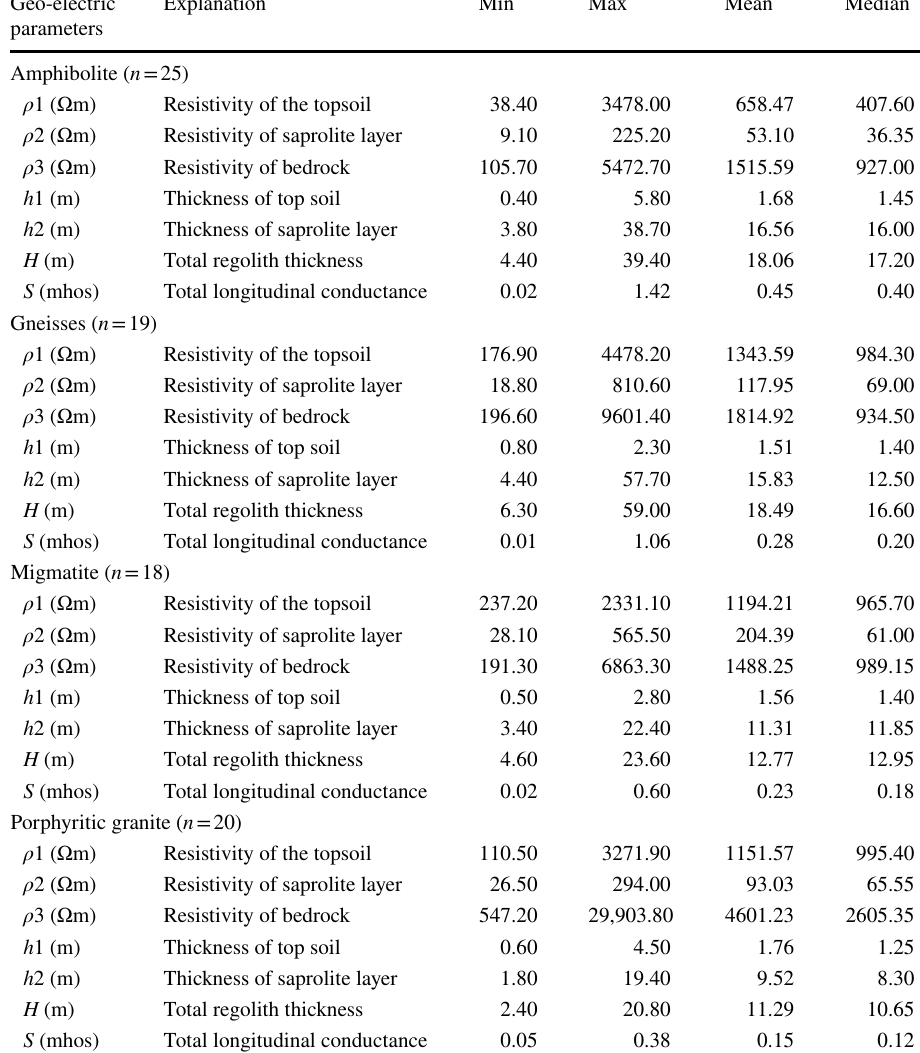
Table 2 Statistics of the geo- electric parameters by bedrocks